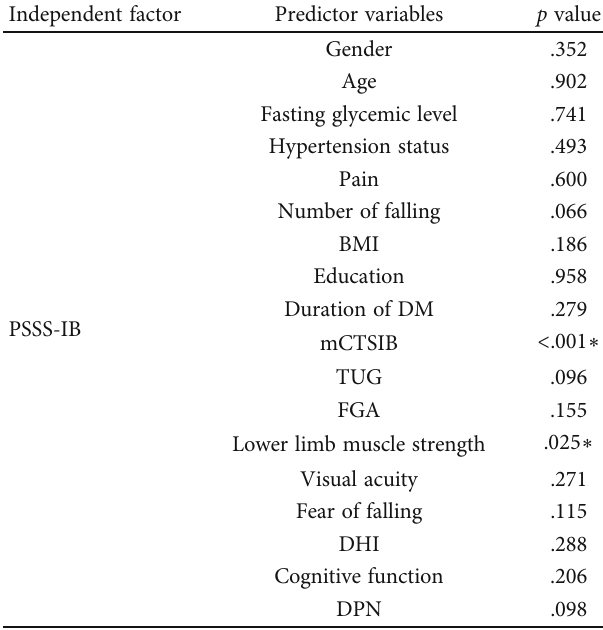
Table 4: The correlation between PSSS-Ina and predictor variables in T2DM with vertigo complaint and positive VD tests.